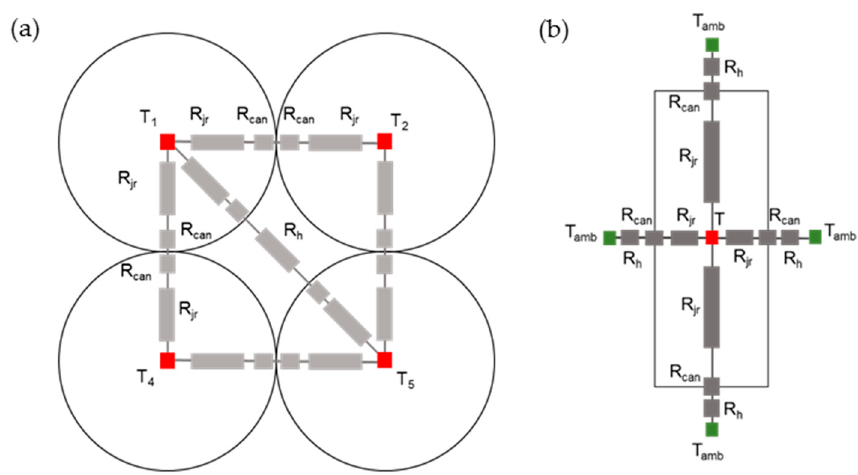
Figure 2. ( a ) Heat transfer resistance network within the module; ( b ) Heat transfer resistance network